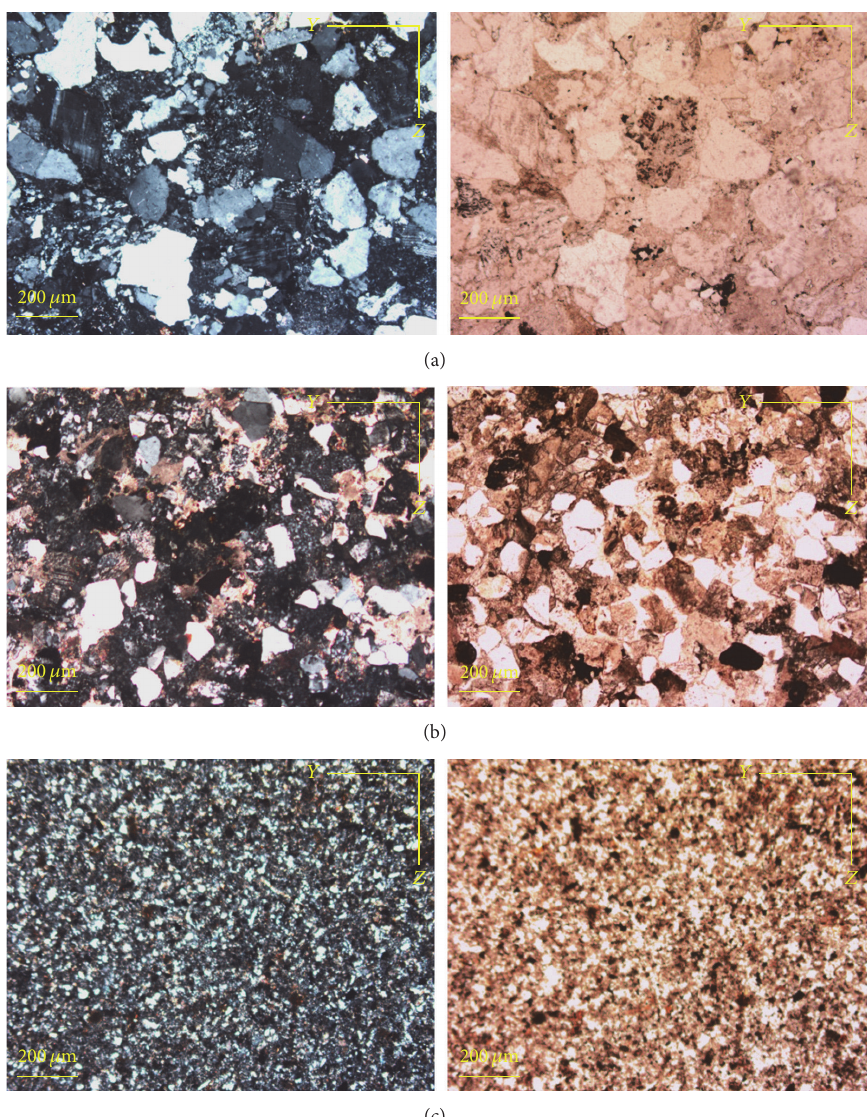
Figure 3: Microscopic images of thin sections and corresponding grain size distribution of the three types of